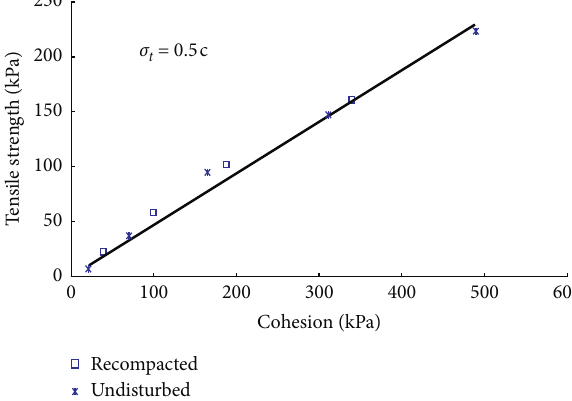
Figure 18: Relationship between cohesion and tensile